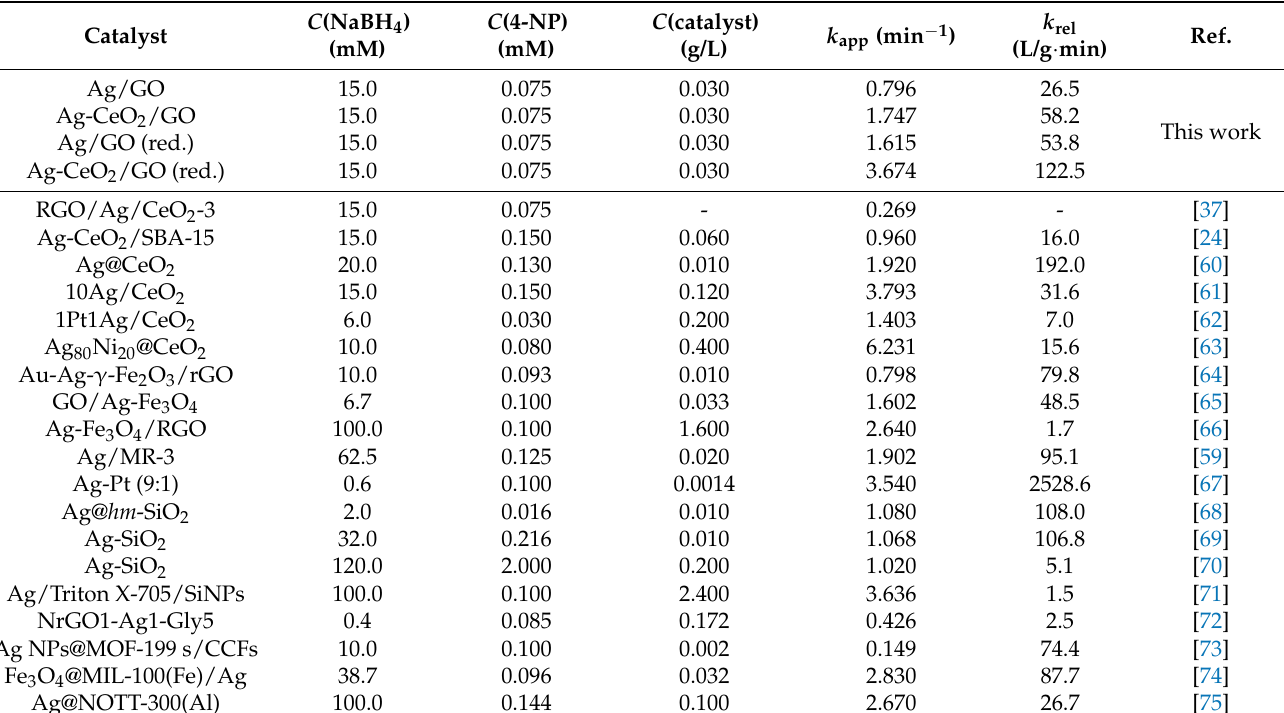
Table 4. Data of catalytic experiments for 4-NP-to-4-AP reduction with NaBH 4 at atmospheric pressure and room temperature in an aqueous medium ( C (catalyst) is the catalyst concentration in the reaction mixture, and k rel is the relative rate constant: k rel = k app / C